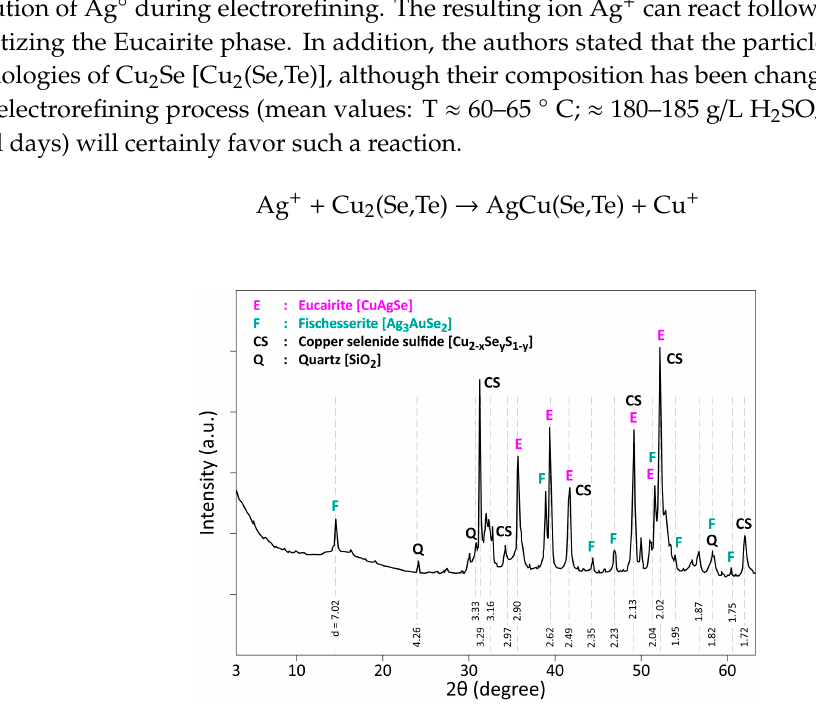
Figure 3. XRD patterns of CAS raw sample.